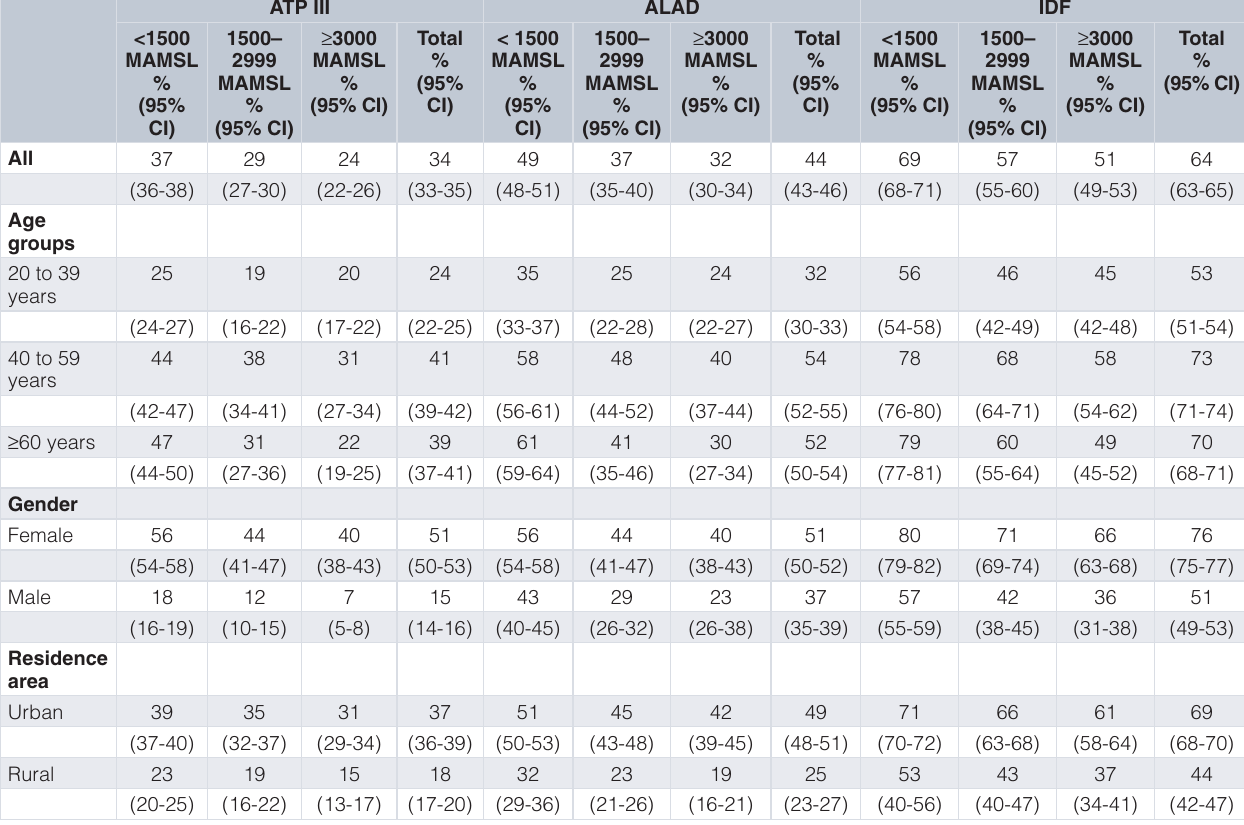
Table 2. Abdominal obesity prevalence by demographic and nutritional factors at different altitude